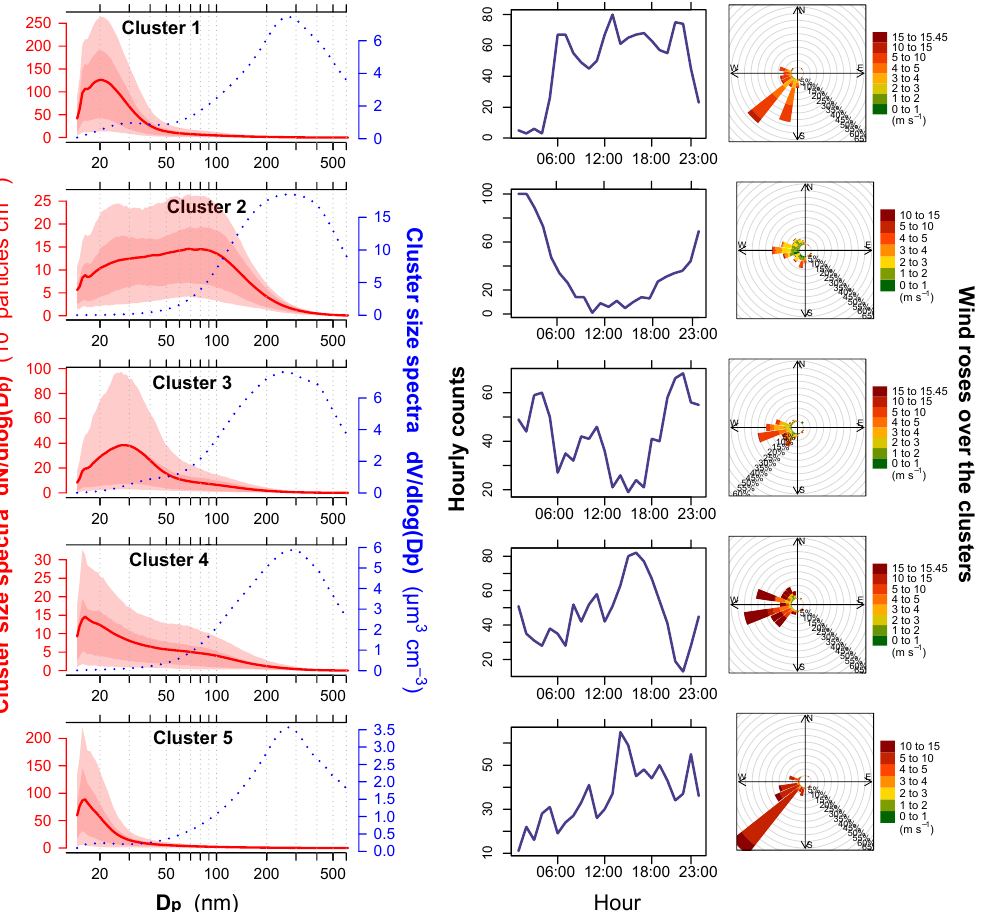
Figure 4. Results of cluster analysis for the cold season data. Average cluster PNSD spectra (left) are reported as solid red lines along with (i) their 10th, 25th, 75th and 90th percentile spectrum as shaded areas, (ii) the volume size distributions (dotted blue line), (iii) the hourly counts, and (iv) the wind roses associated with each